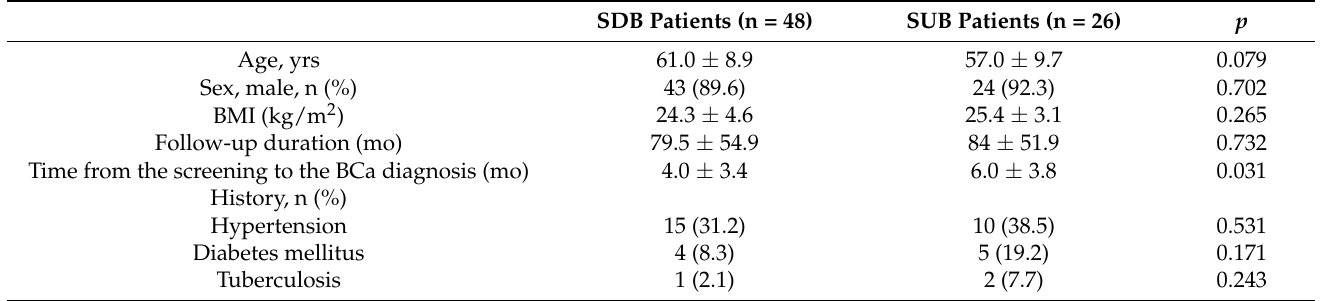
Table 1. Baseline characteristics of patients with screen-detected bladder cancer and screen- undetected bladder